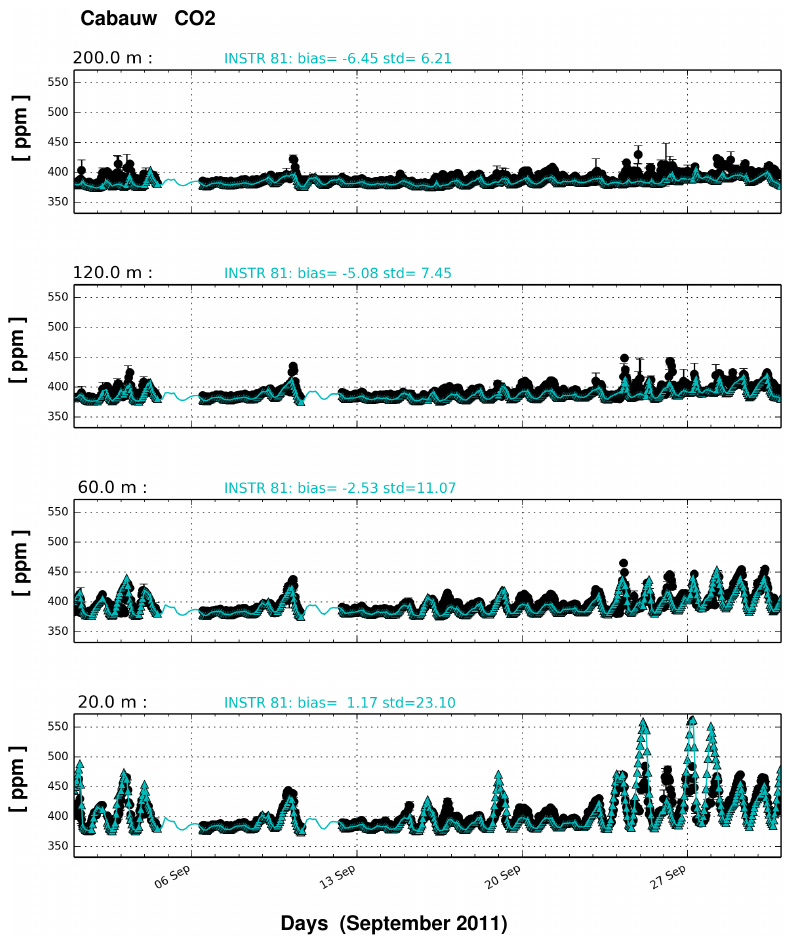
Figure 10. Hourly mean CO 2 dry molar fraction [ppm] at the ICOS site at Cabauw (Netherlands) from measurements (dark circles) and hindcast (blue triangles) in September 2011 at several sampling heights. The solid blue line shows the hourly values of the CO 2 hindcast even in the absence of observations. The values for the bias and standard deviation [ppm] are shown in the title above each